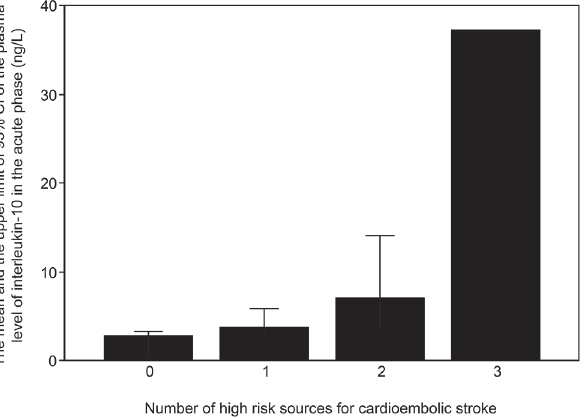
Fig 2. Acute Phase Interleukin (IL)-10 Plasma Concentration (ng/L) in 141 Patients with Cardioembolic Stroke According to the Number of High Risk Source Findings Presented by the European Association of Echocardiography (EAE). In patients with no EAE high risk factors, the mean IL-10 concentration was 2.7 ± 3.1 ng/L (n = 104; range: 0.3 – 16.3 ng/L); with one risk factor it was 3.7 ± 5.5 ng/L (n = 26; range: 0.3 – 23.6 ng/L), with two risk factors 7.0 ± 10.0 ng/L (n = 10; range: 1.29 – 34.8 ng/L) and with three risk factors the IL-10 measurement was 37.2 ng/L (n =